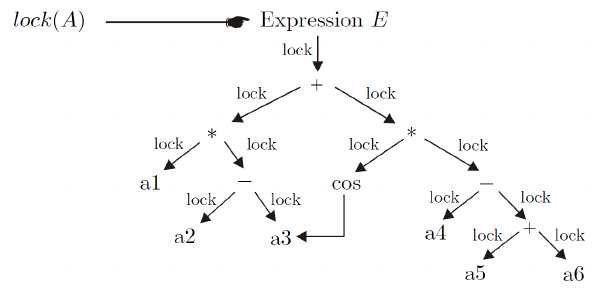
Figure 7. Locking an expression in memory.